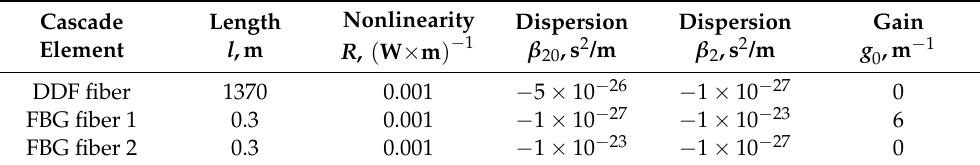
Table 1. Parameters of the fiber cascade